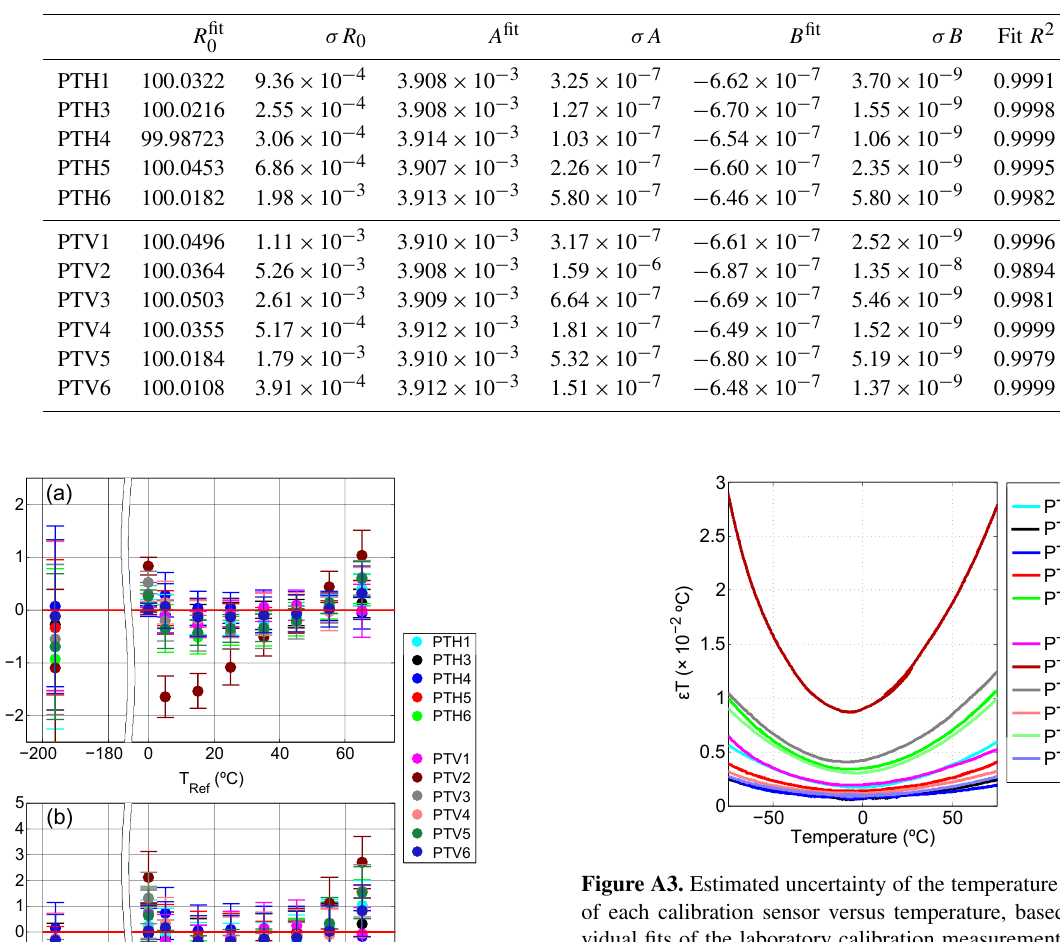
Table A1. Fitted parameters and 1 standard deviation uncertainties of the Callendar-van-Dusen (CVD) coefficients (Eq. A1) for the horizontal and vertical calibration strings, PTH and PTV, obtained during the laboratory calibration, July 2014. The parameter C was fixed at − 4 . 183 × 10 − 12 (cid:127) ◦ C − 3 .